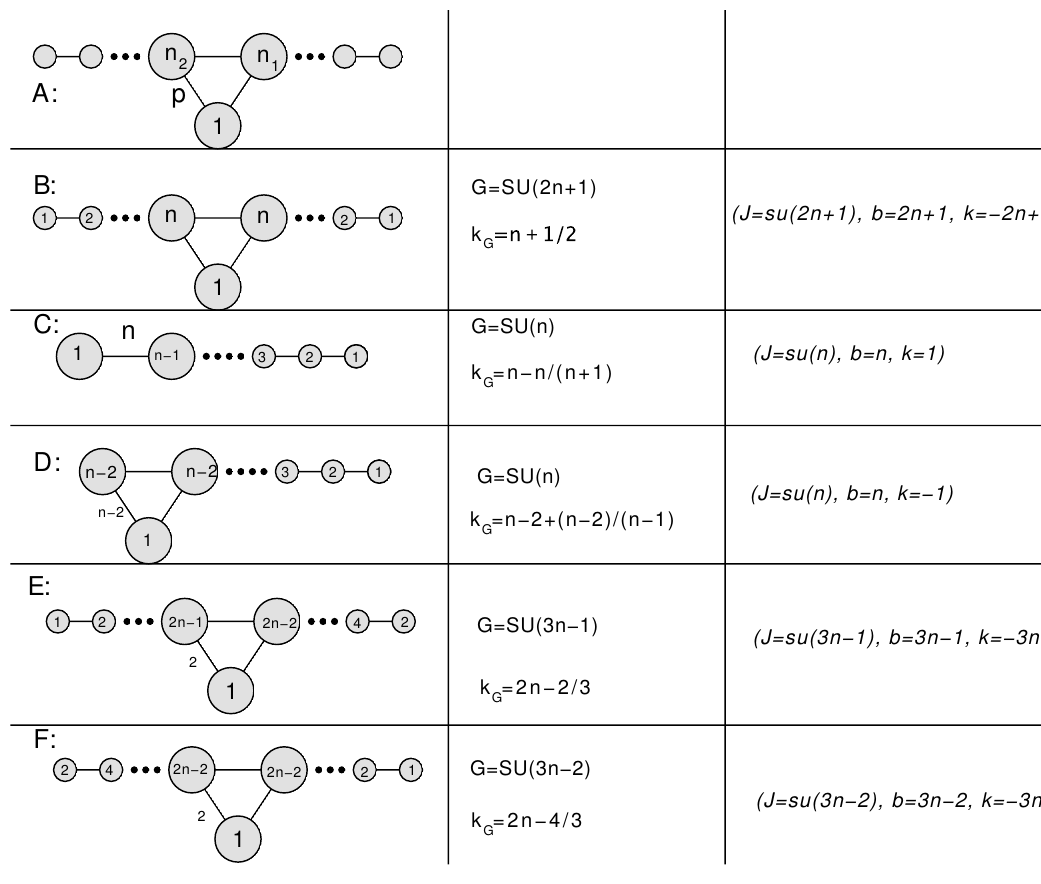
Figure 1 . 3d Mirror descriptions for some Argyres-Douglas theories considered in this paper, whose (cid:13)avor symmetry is SU . Here, the number n assigned to the edges mean that there are n copies of the bifundamental hypermultiplet. As usual, the overall U(1) factor has to be modded out. A is the general structure of a quiver whose (cid:13)avor symmetry would be a simple SU group. B (cid:0) F are examples. We also list the (cid:13)avor central charge here, and the corresponding theory in terms of the label ( J b [ k ] ; F